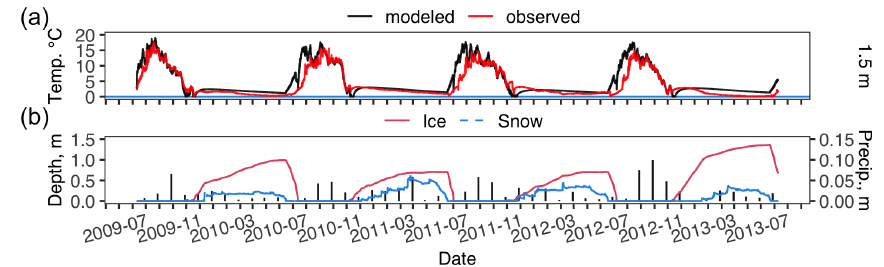
Figure 2. Fox Den Lake modeled and observed water temperature at 1.5m (a) and modeled lake ice depth, modeled lake snow depth, and measured monthly precipitation (vertical black bars) (b) .